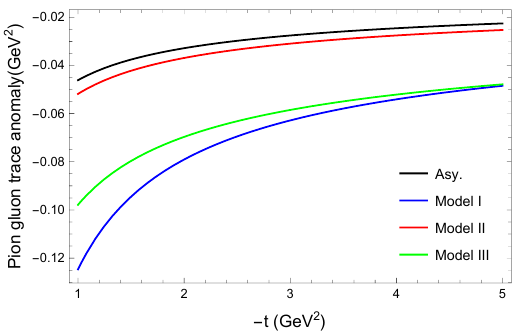
F 2 | P i as function of momentum transfer 2 g